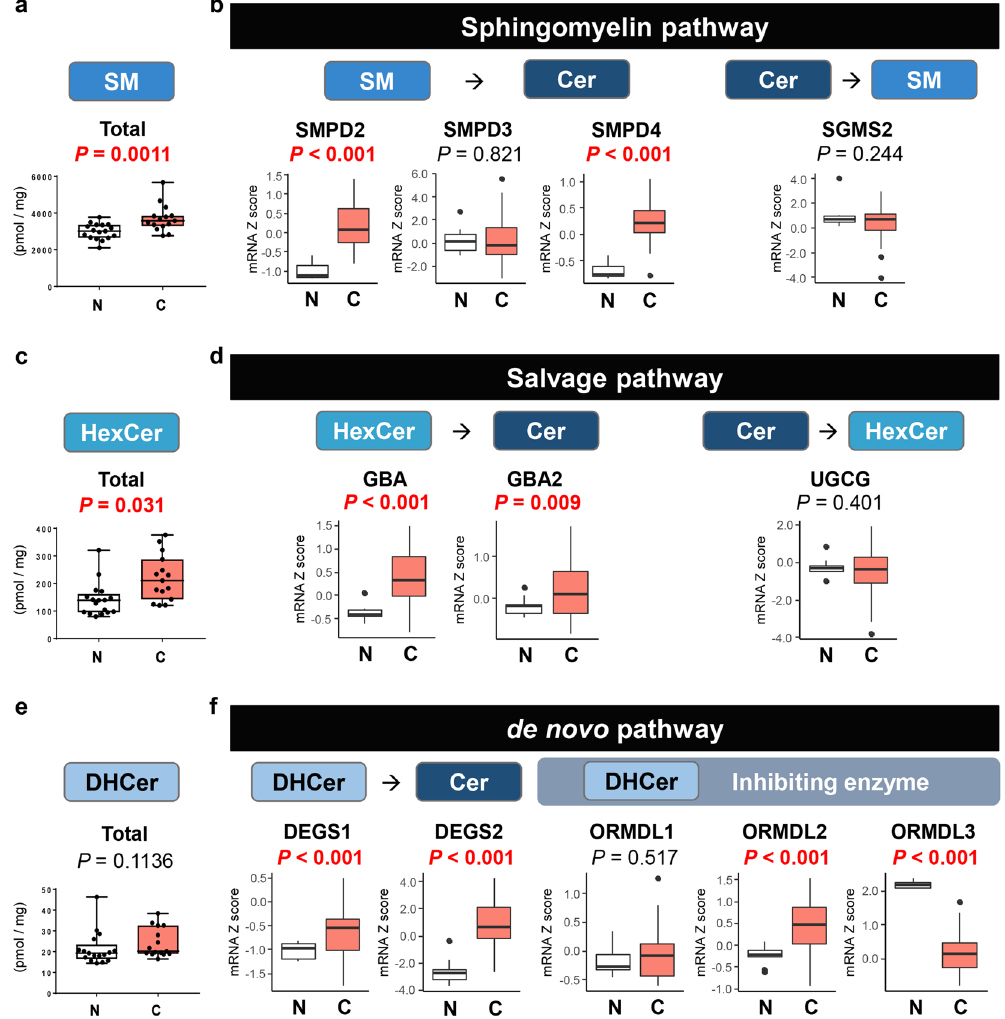
Figure 1. The major metabolic pathways for ceramide synthesis are enhanced in biliary tract cancer compared with normal biliary tract tissue. ( a ) Total SM levels in biliary tract cancer (n = 15) and normal biliary tract tissue (n = 17) were determined by LC-ESI-MS/MS. ( b ) The gene expression levels of SMPD2, SMPD3, SMPD4 and SGMS2 in TCGA cohort (36 and 9 samples of cancer and non-cancer tissue in cholangiocarcinoma cohort) were analyzed. ( c ) Total HexCer levels in biliary tract cancer (n = 15) and normal biliary tract tissue (n = 17) were determined by LC-ESI-MS/MS. ( d ) The gene expression levels of GBA, GBA2 and UGCG in TCGA cohort (36 and 9 samples of cancer and non-cancer tissue in cholangiocarcinoma cohort) were analyzed. ( e ) Total DHCer levels in biliary tract cancer (n = 15) and normal biliary tract tissue (n = 17) were determined by LC- ESI-MS/MS. ( f ) The gene expression levels of DEGS1, DEGS2, ORMDL1, ORMDL2 and ORMDL3 in TCGA cohort (36 and 9 samples of cancer and non-cancer tissue in cholangiocarcinoma cohort) were analyzed. Mean values are shown by the horizontal lines. Two-sided P values < 0.05 were considered statistically significant (Mann-Whitney U test). N: normal biliary tract tissue; C: biliary tract cancer